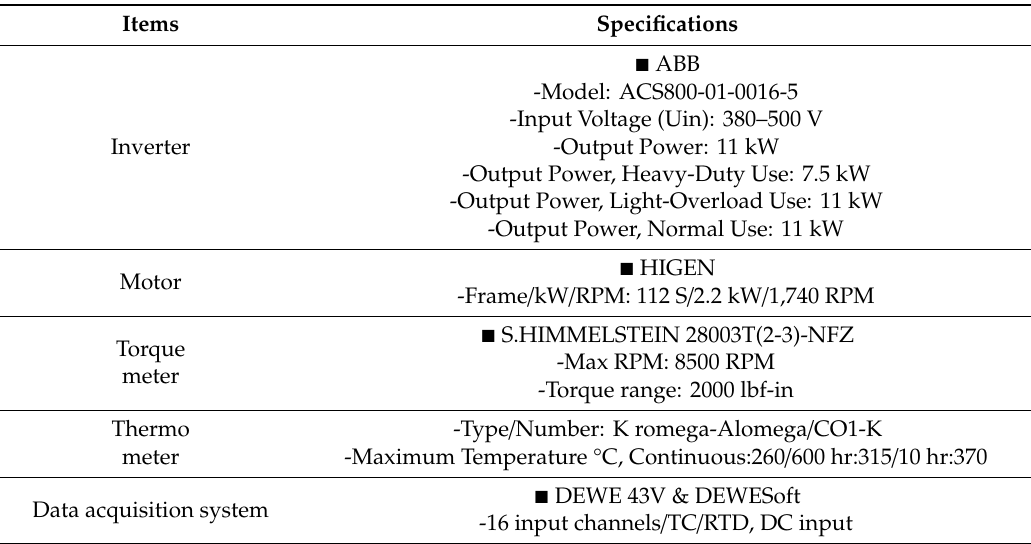
Table 3. Specifications of components for test rig.